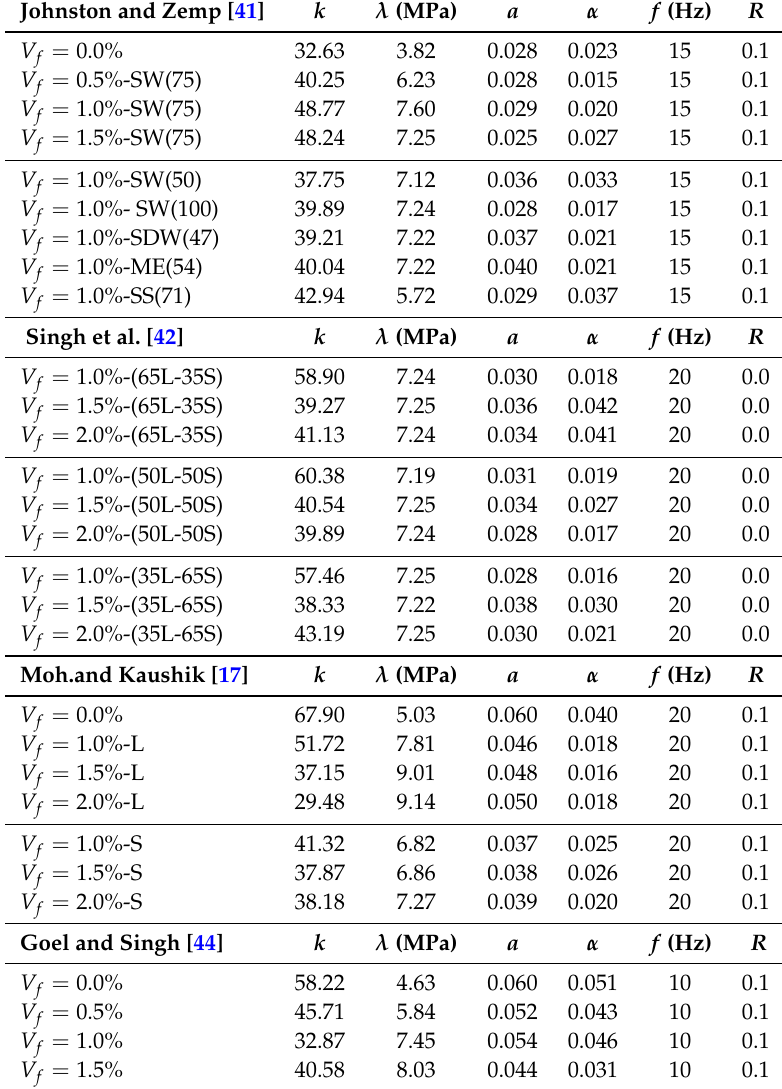
Table 5. Model parameters and loading frequency, stress ratios for SFRC flexural fatigue tests carried out by Johnston and Zemp 1991 [41], Singh et al. 2005 [42], Mohammadi and Kaushik 2005 [17] and Goel and Singh 2014